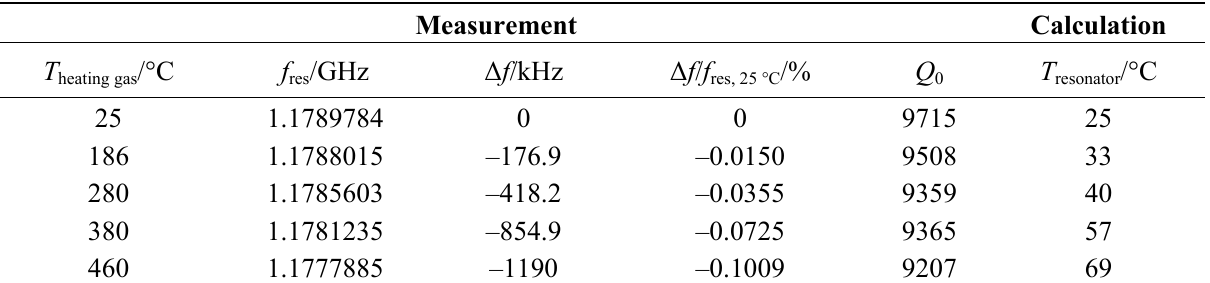
Table 1. Influence of the heating on the microwave measurement: heating gas temperature, frequency shift and quality factor. The resonator temperature is calculated from the frequency